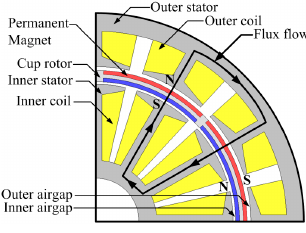
Figure 5. A quarter section of the double-stator permanent magnet machine.